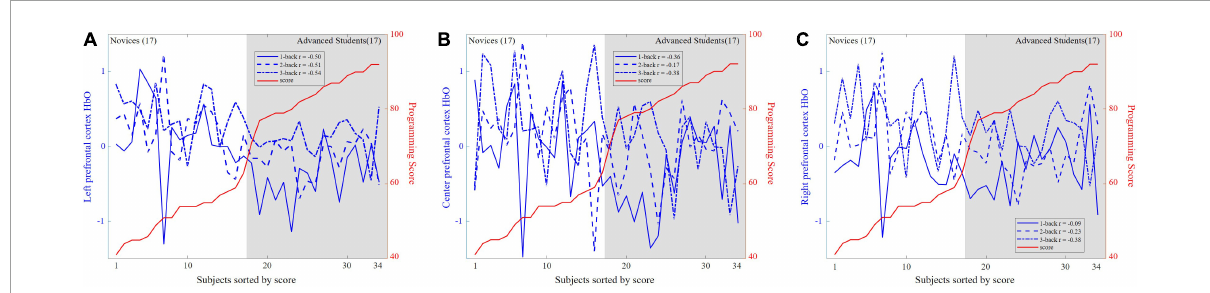
FIGURE7 Correlations between hemoglobin (HbO) and programming score for the three n-back levels in the left, center, and right prefrontal cortices. (A) Left prefrontal cortex. (B) Center prefrontal cortex. (C) Right prefrontal cortex.